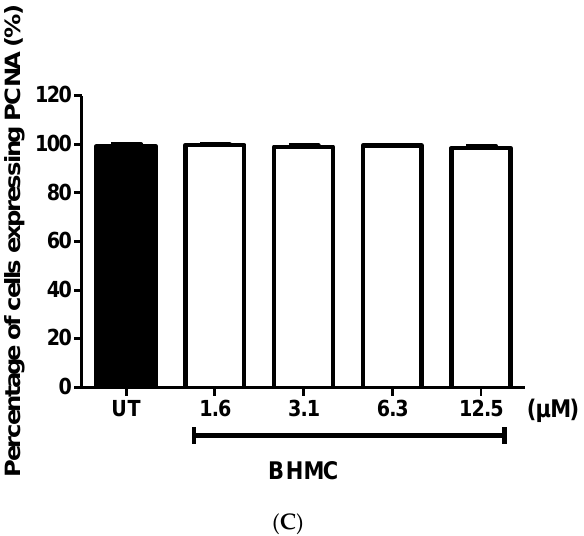
Figure 1. Cell viability and cell proliferation assays. ( A ) MDA-MB-231 cells (1 × 10 5 cells/mL) were treated with different concentrations of BHMC for 24 h and detected for cell viability using MTT assay. ( B ) MDA-MB-231 cells (2 × 10 4 cells/mL) were fixed and stained with anti-PCNA, Alexa Fluor 568 goat anti-mouse secondary antibody (red), Hoechst (blue), and Alexa Fluor 488 phalloidin (green) after treating with BHMC for 24 h using indicated concentrations (mag. 400×). The arrows indicate the presence of PCNA in the cytoplasm of the cells. ( C ) The graph is plotted to represent the presence of PCNA in 150 MDA-MB-231 cells for each condition. All values are the mean ± S.E.M of three independent experiments. *** p < 0.001, which is significantly different from the untreated group.